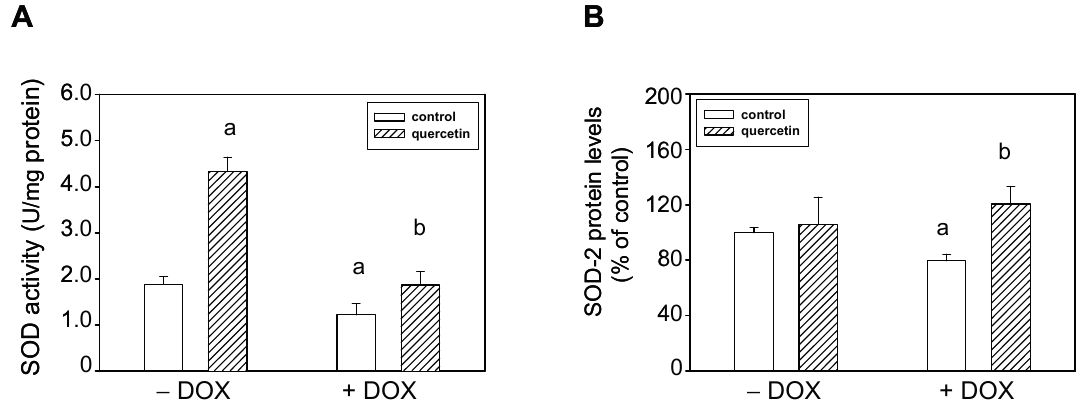
Figure 5. Effects of QCT and DOX treatment on superoxide dismutase (SOD) total activities and protein levels. ( A ) The SOD activities were analyzed using the SOD Assay kit in tissue samples of the left ventricle. The specific activities are expressed in units per mg of proteins and are presented as mean ± S.E.M.; ( B ) Quantitative analysis of SOD-2 protein levels. Data are expressed as a percentage of value for corresponding control. Each bar represents mean ± S.E.M. of seven independent tissue samples per group. Statistical significance is revealed by Student’s unpaired t -test, a p < 0.05 vs. control saline-treated ( − DOX) rats; b p < 0.05 vs. DOX-treated (+DOX) rats. 2.5. Prolonged Application of Quercetin Improves Postischemic Recovery of Cardiac Function